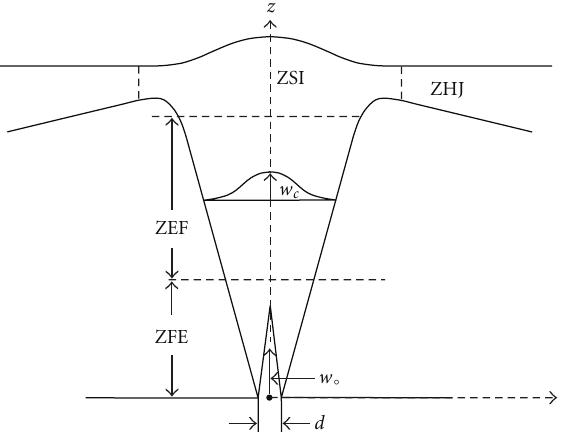
Figure 1: Layout of vertical jet in shallow